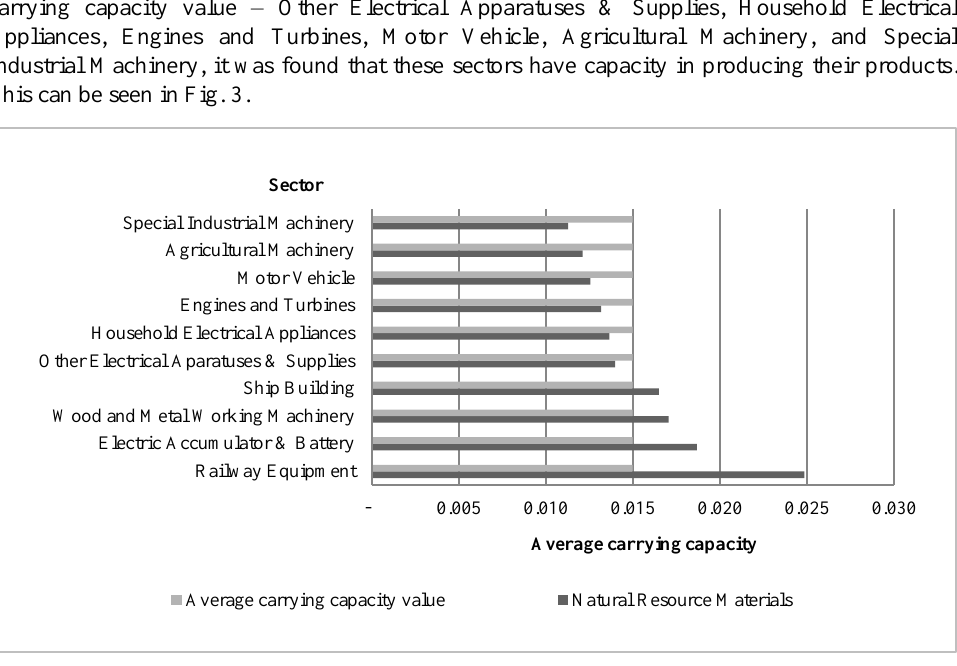
Fig. 3. Natural Resource Materials